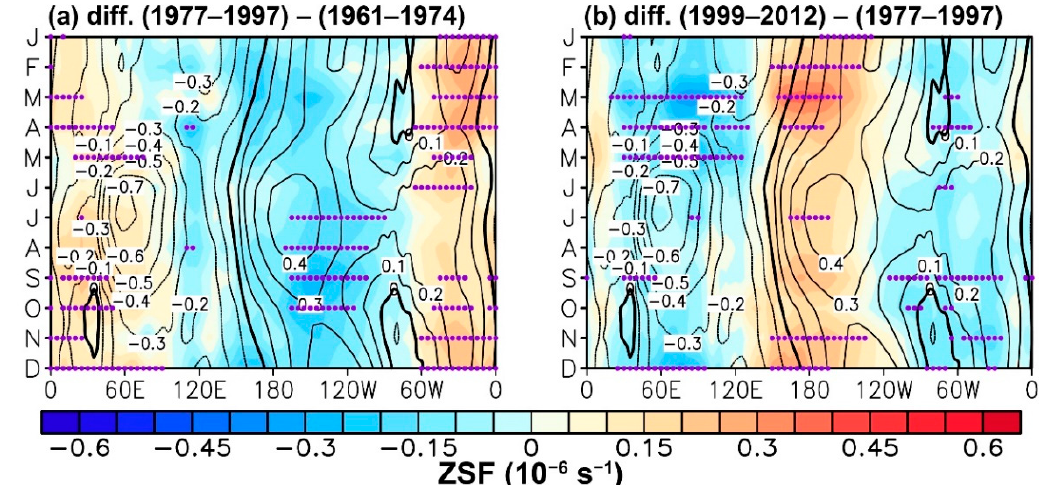
Figure 6. Contours in ( a ) and ( b ): mean state (1961–2012) of the monthly mean of vertically averaged zonal circulations along the equator (5° S–5° N); shading: differences in the monthly mean of vertically averaged zonal circulations between ( a ) the periods 1961–1974 and 1977–1997 and ( b ) the periods 1977–1997 and 1999–2012. The composites which are statistically significant at the 5% confidence level are dotted in purple.